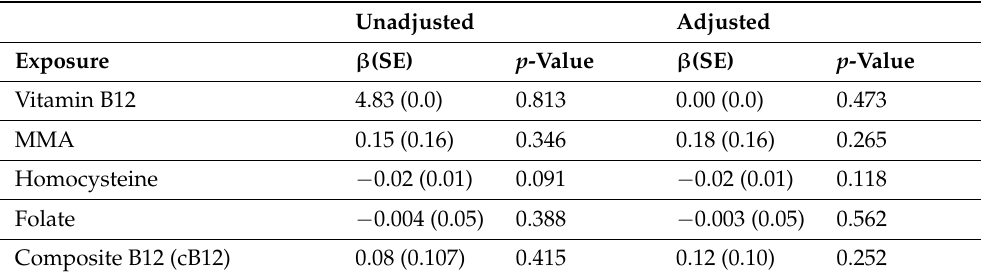
Table 4. Association between maternal B12 and folate markers with neonatal birth weight in the MAASTHI cohort. Unadjusted Adjusted Exposure β (SE) p -Value β (SE) p -Value Vitamin B12 MMA